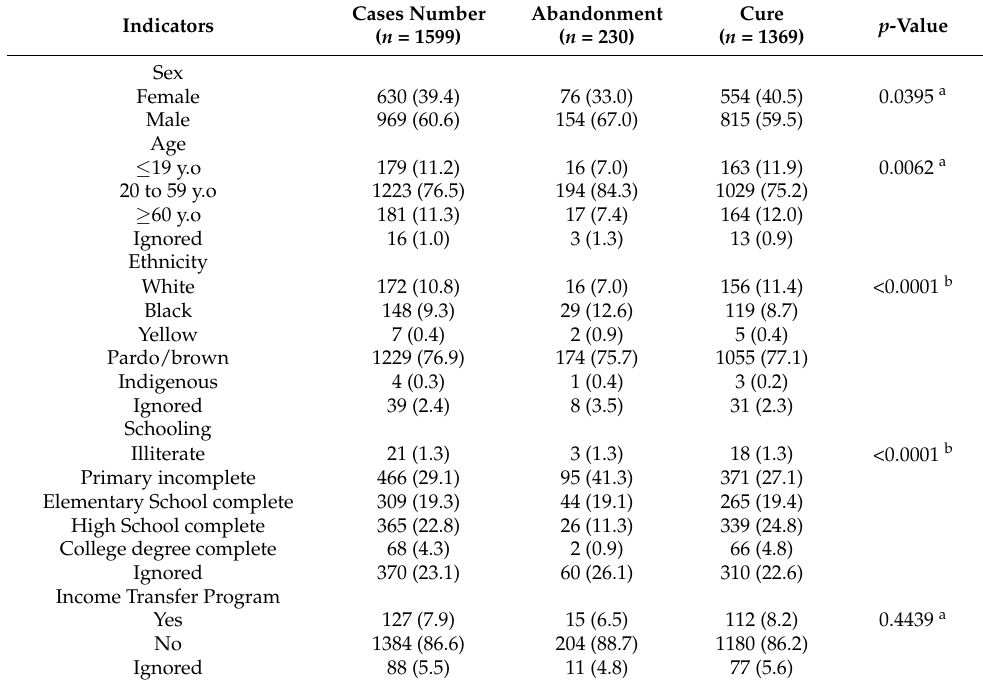
Table 3. Socioeconomic characteristics of the cases with the Treatment abandonment outcome and Tuberculosis cure in Ananindeua from 2017 to